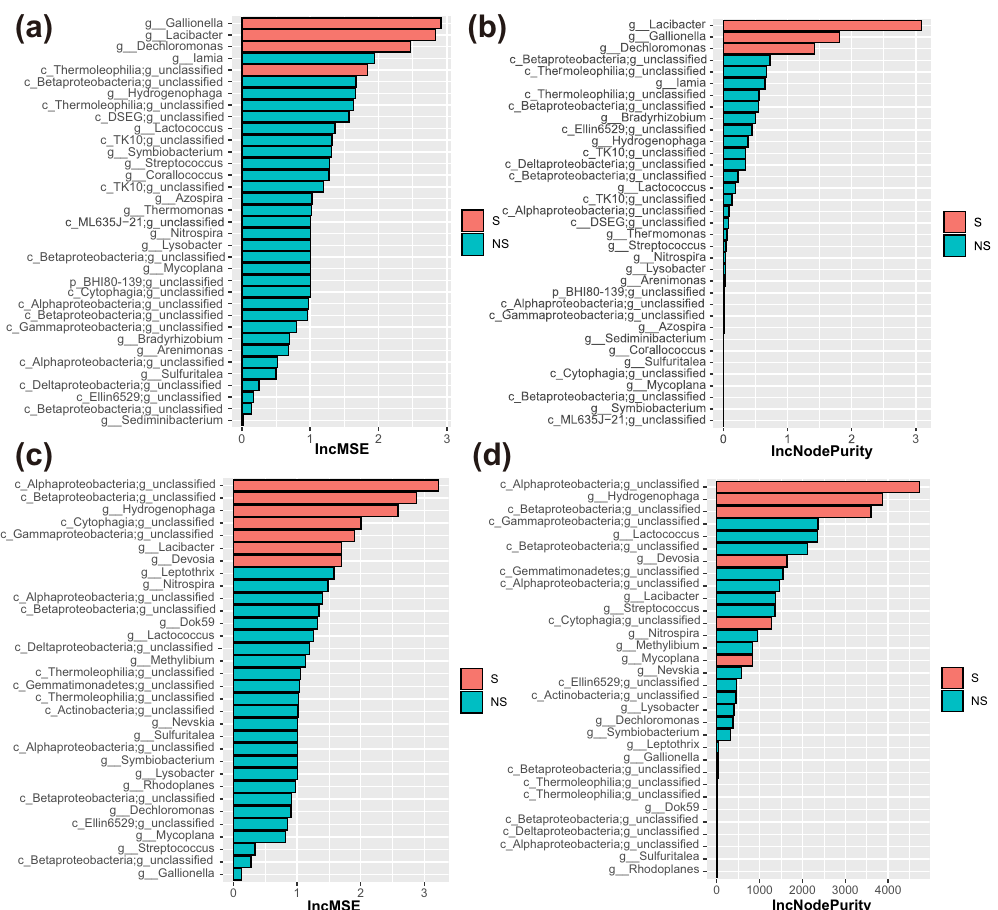
Fig. 6 Representative taxa that responded positively to metal corrosion identi fi ed by Random Forest. The Increase in Mean Decrease Accuracy (IncMSE) ( a ) and Increase in Node Purity (IncNodePurity) ( b ) of random forest model calculated with the relative abundance of enriched microorganisms and metal mass loss data, IncMSE ( c ) and IncNodePurity ( d ) of random forest model calculated with the relative abundance of enriched microorganisms and redox potential data. Note, S means p -value < 0.05; NS means p -value >